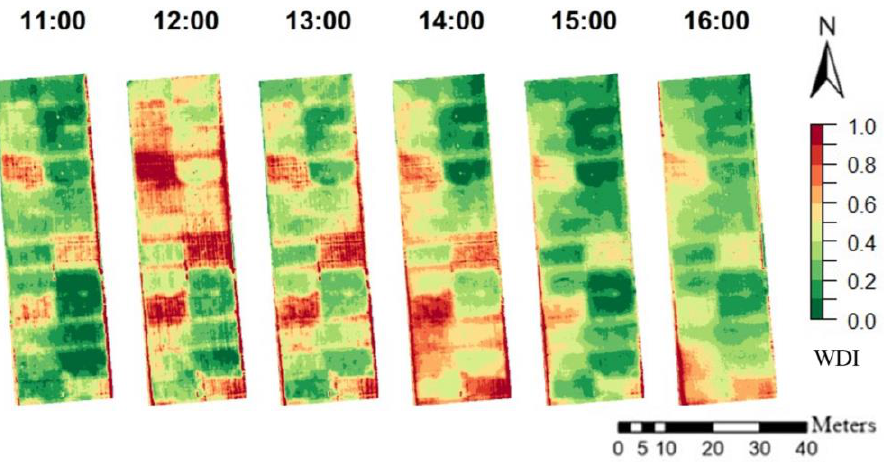
Figure 6. WDI maps calculated based on NDVI for the diurnal winter wheat flights on 23 April 2020. Table 6. Correlation of average WDI for each irrigation treatment to soil water content (SWC, mm), stomatal conductance g s (mmol m −2 s −2 ), and leaf water potential (LWP, mPa) (see Table 1 for treat-